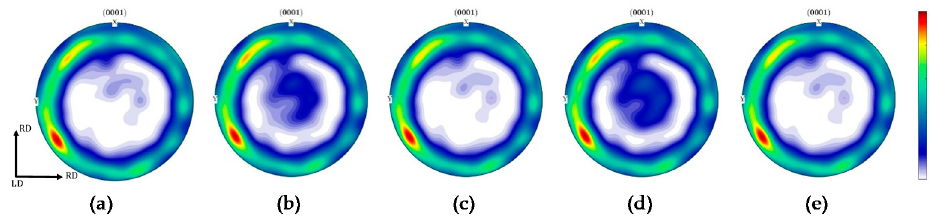
loading along the extrusion direction (After Yaghoobi et al. [9]).